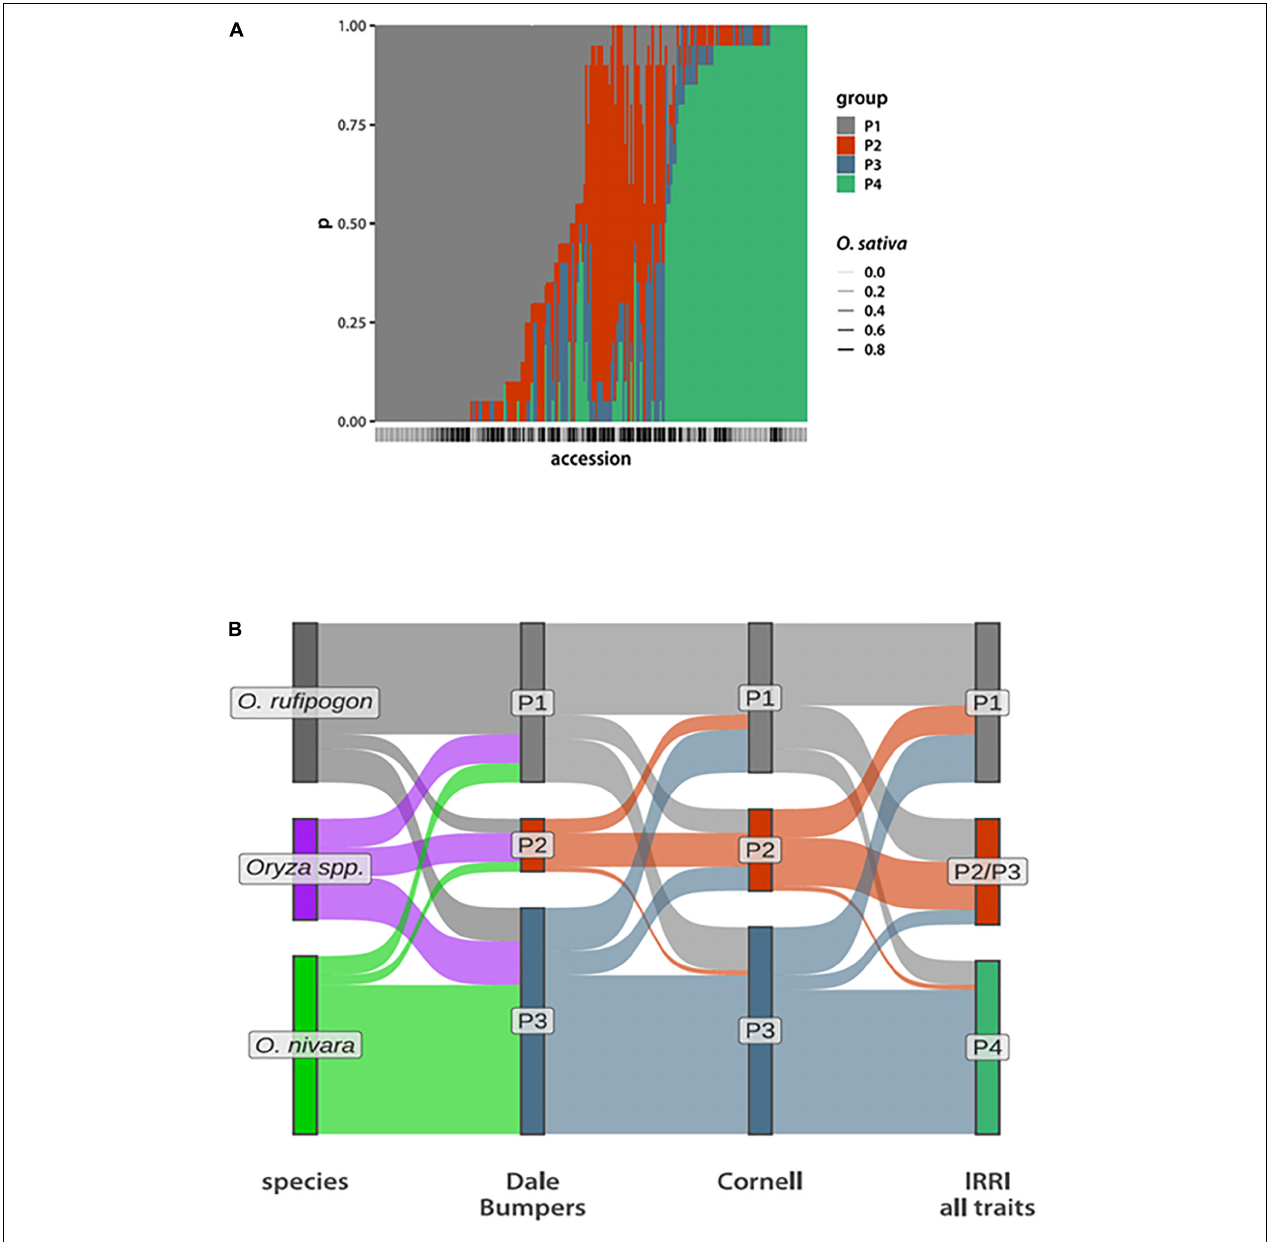
FIGURE 1 | Phenotypic group composition. (A) Bar plot depicting posterior probabilities that a given accession (along the x -axis) belongs to each of the four phenotypic groups. The bars are stacked, with the total probability summing to 1. The bars below the x-axis indicate the O. sativa genome fraction, with the darker bars having a higher O. sativa fraction. (The actual values are in Supplementary Table 2 ) (B) Sankey plots comparing compositions of phenotypic groups inferred from data collected at Dale Bumpers and Cornell assuming N G = 3 compared to species designations and the four groups inferred from data collected at IRRI. Each accession is a single “ribbon” running from left to right and colored according to the grouping to the